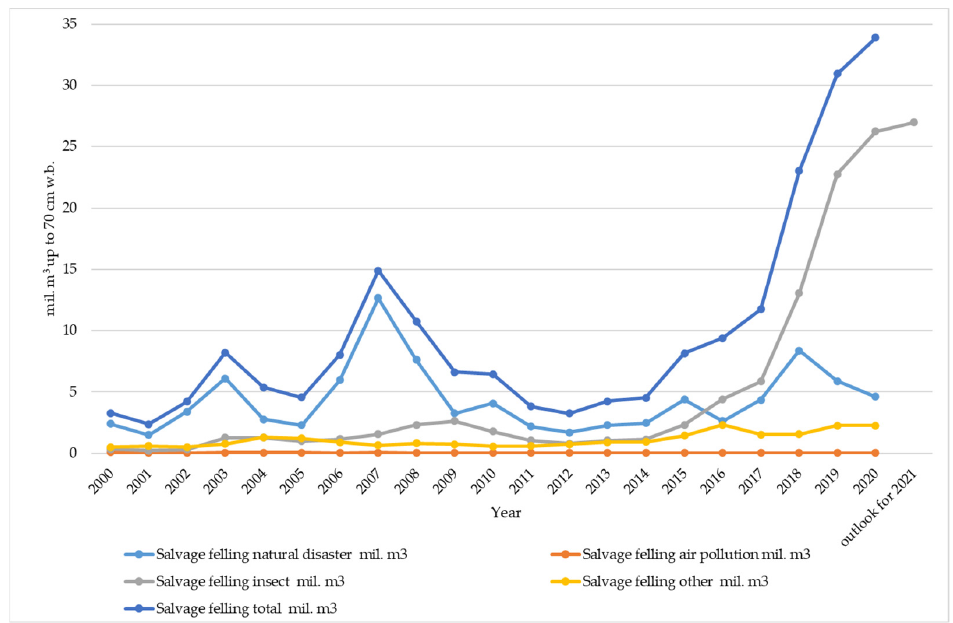
Figure 4. Development of salvage felling. Source : [49].